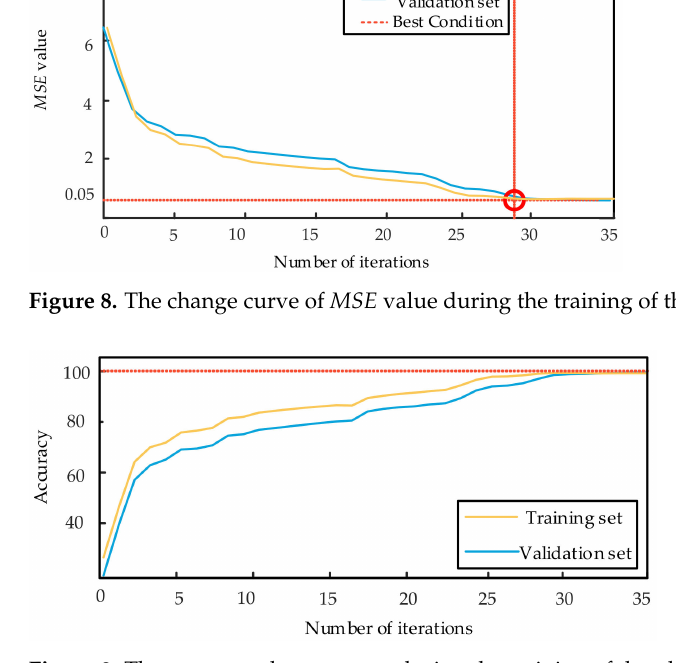
Figure 9. The accuracy change curve during the training of the phase-selection model.